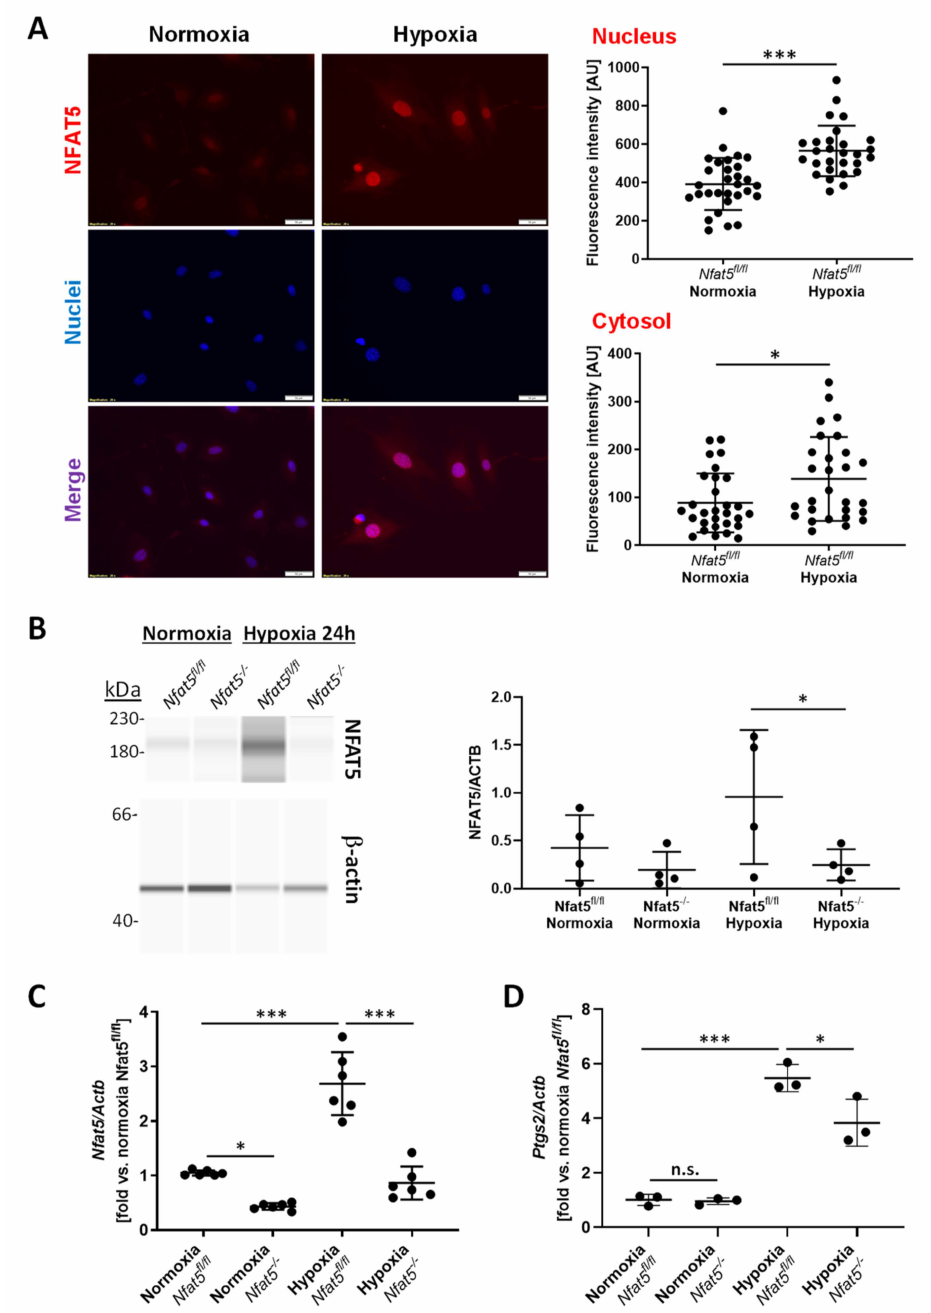
Figure 2. Nfat5 expression in mouse pulmonary artery SMCs. Murine pulmonary